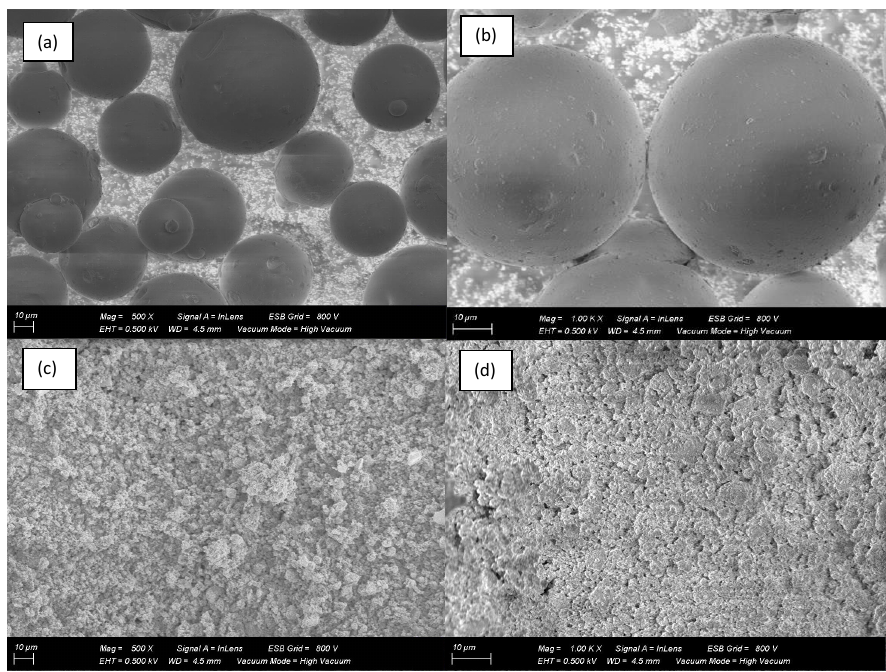
Figure 1. Typical morphology of micro silica particles, with magnification of 500 ( a ), micro silica particles, with magnification of 1000 ( b ), nano silica particles, with magnification of 500 ( c ), and nano silica particles, with magnification of 1000 ( d